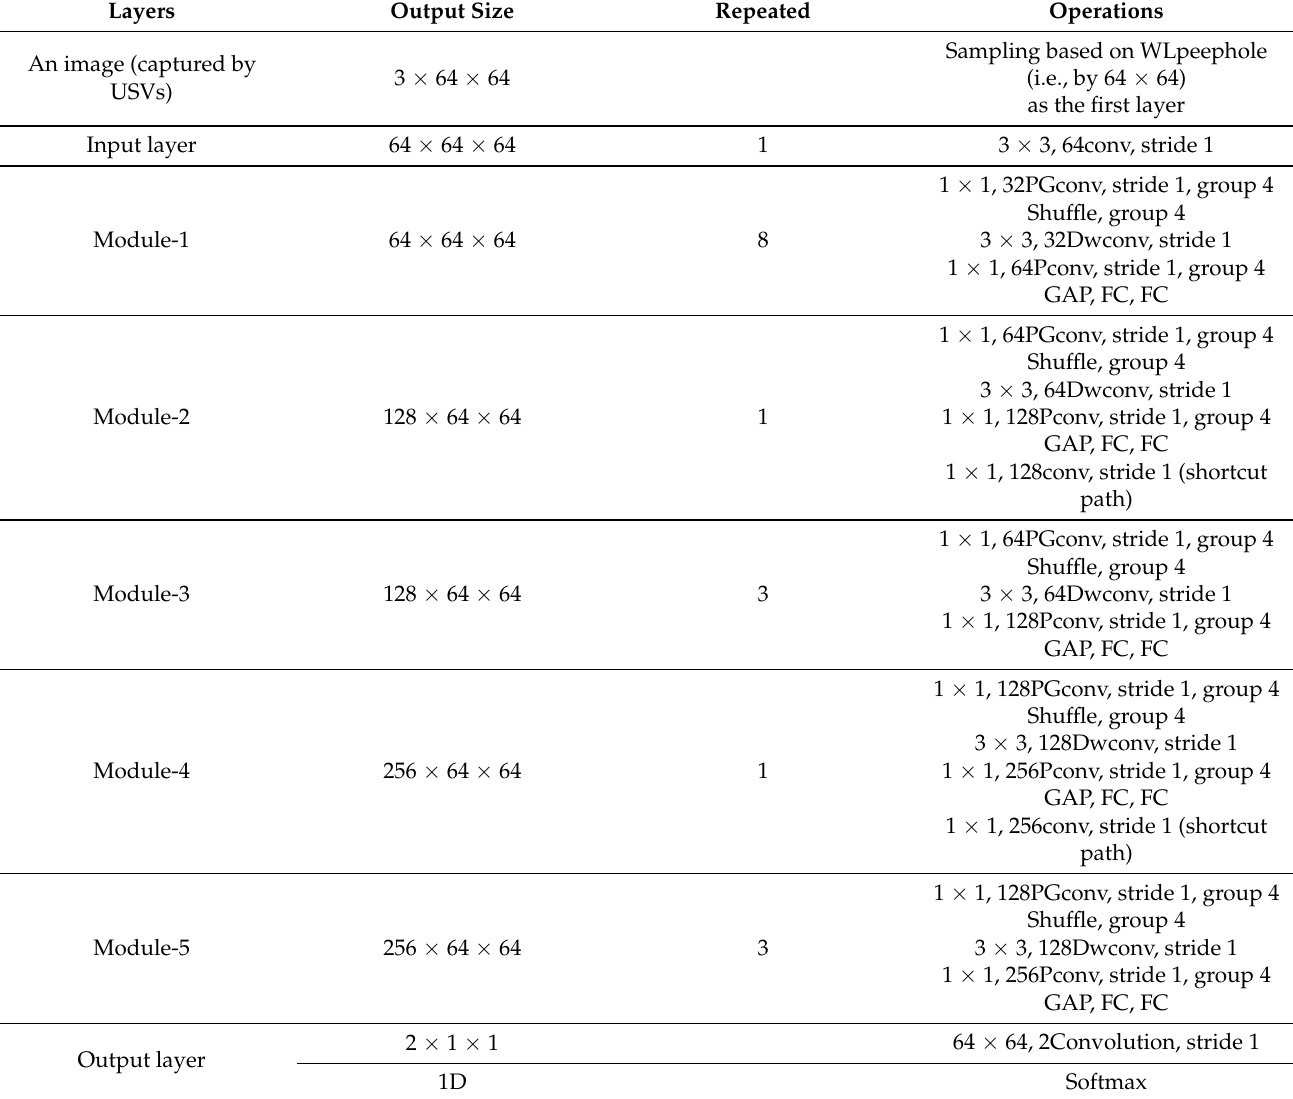
Table 1. The deep architecture of